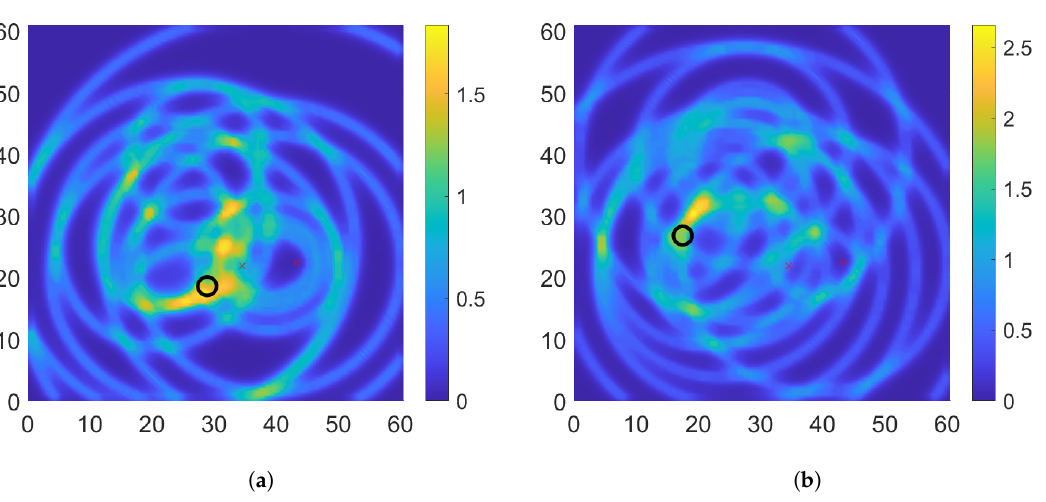
Figure 10. Damage maps with brute force method ( a ) D1 ( b )